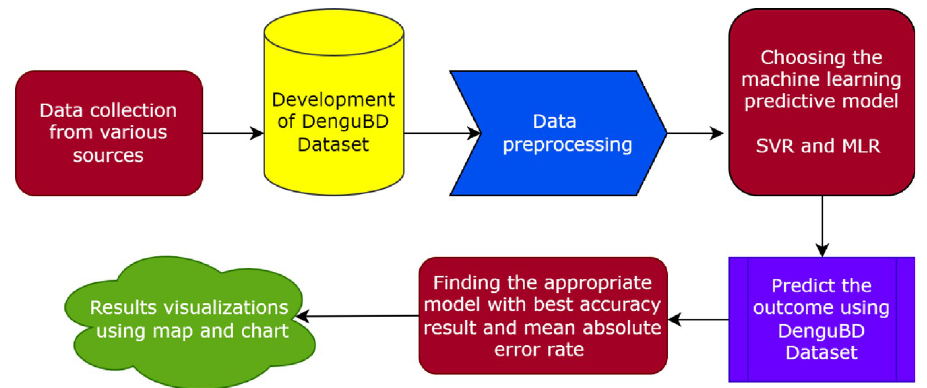
Fig 3. Stepwise workflow diagram for predicting the dengue cases based on the proposed